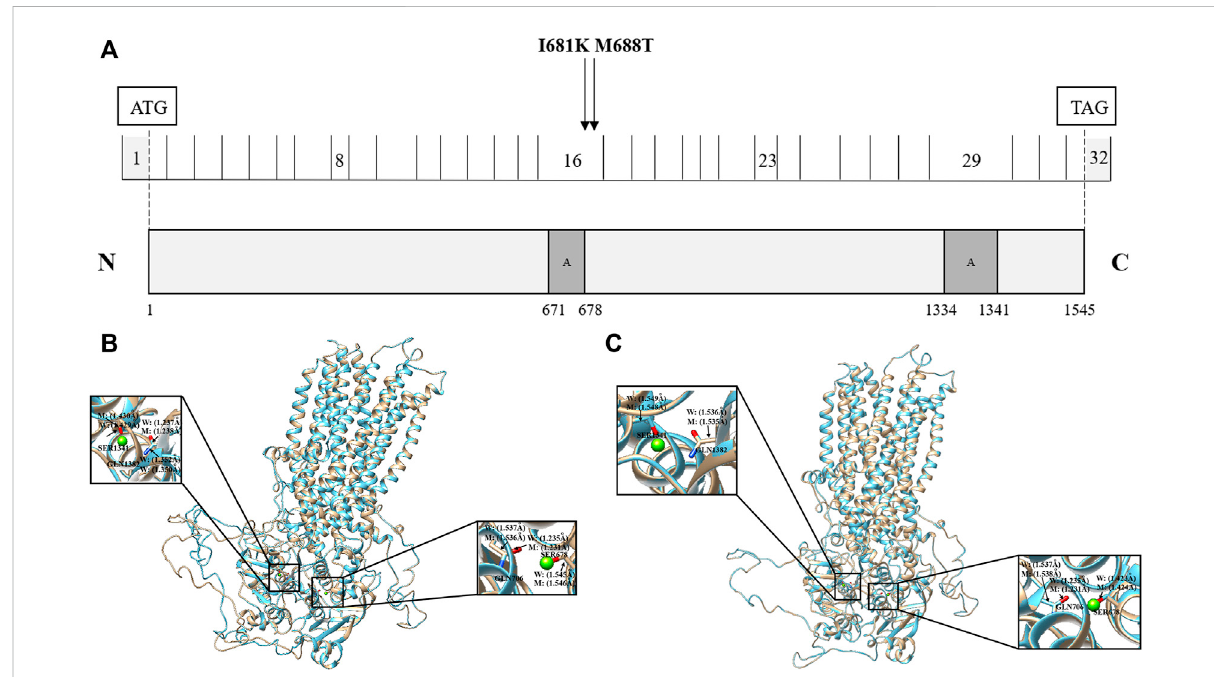
FIGURE 4 Effectsof ABCC2 Ile681LysandMet688Thrvariantsontheproteinsequenceandstructure. (A) Distributionof ABCC2 variants. ABCC2 isa1545- amino acid protein containing two ATP binding cassette domains. Schematic representation of ABCC2 NM_000,392.4 cDNA and protein showing the locations of the two novel possible pathogenic variants, Ile681Lys and Met688Thr, detected in two out of 249 ICP patients. Effects of ABCC2 Ile681Lys (B) and Met688Thr variants (C) on the protein structure. The three-dimensional models of reference and modi fi ed (Ile681Lys and Met688Thr) ABCC2 are shown in gold and blue rounded structures, respectively. The enlarged portion shows that the two ATP binding cassette regions have small changes in the chemical bond lengths. (A) The ATP binding cassette